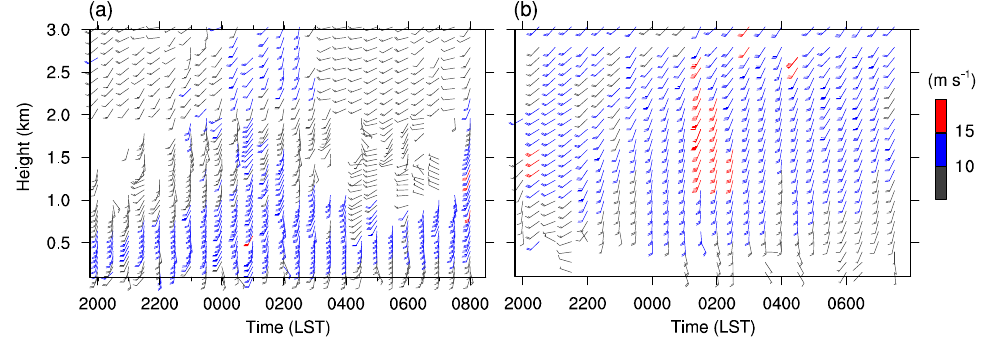
Figure 5. Time–height distribution of horizontal wind (wind barbs, a full barb is 5 m s − 1 ) from the wind profiler at ( a ) Hailing Island and ( b ) Guangzhou station. Horizontal wind with speeds of 10 − 15 m s − 1 and >15 m s − 1 are marked in blue and red, respectively.